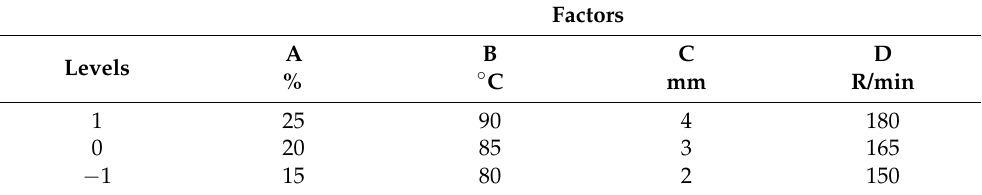
Table 2. Factor level table.